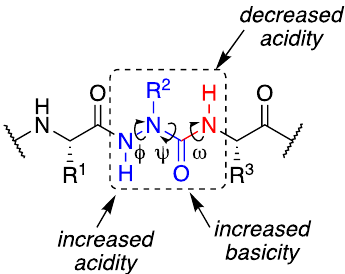
Figure 1. Aza-amino acid (in blue) creates one face with increased hydrogen bonding properties and one with reduced hydrogen bonding capacity.